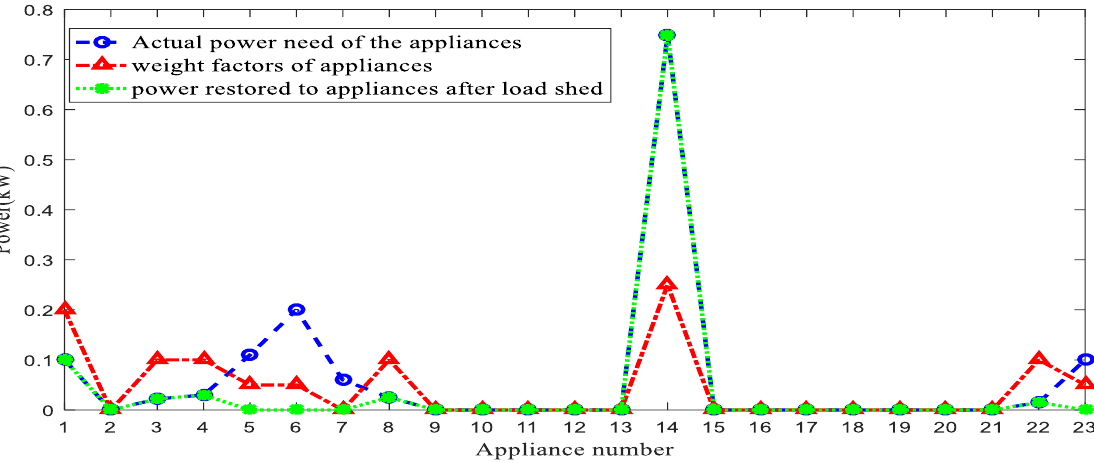
Figure 14. Actual load to meet, weight factors assigned for priority of appliance, and power restored due to EVs for residential user 8.